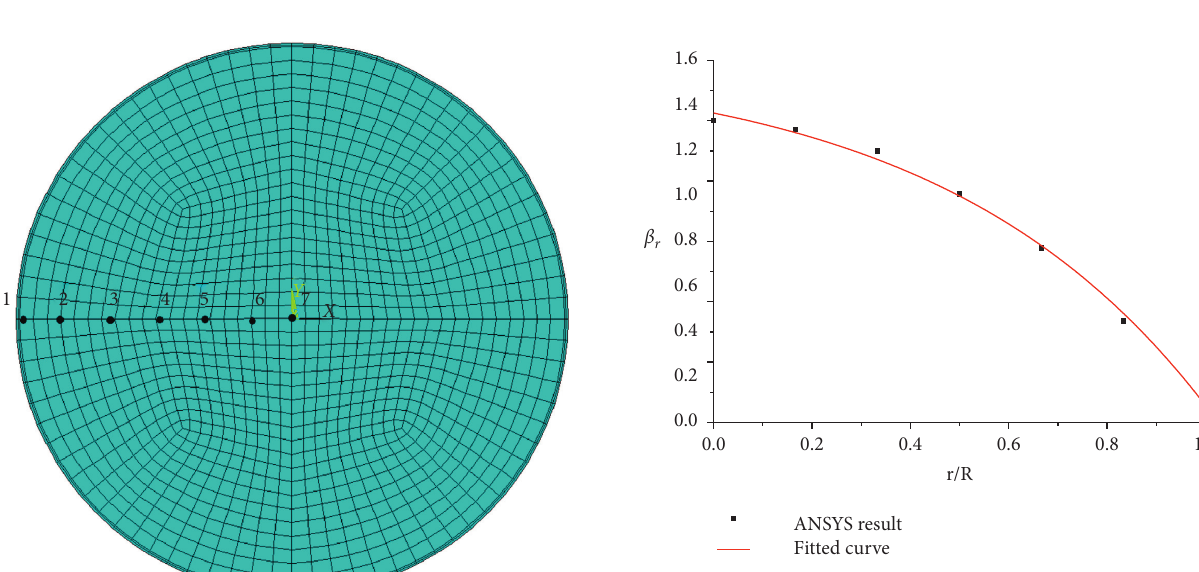
Figure 13: Fitted curve of parameter β r . Note. A comparison of formulas (4) and (5) indicates that the expressions for the CFST diameter parameter, α D , and the CFST location parameter, β r , are given in similar